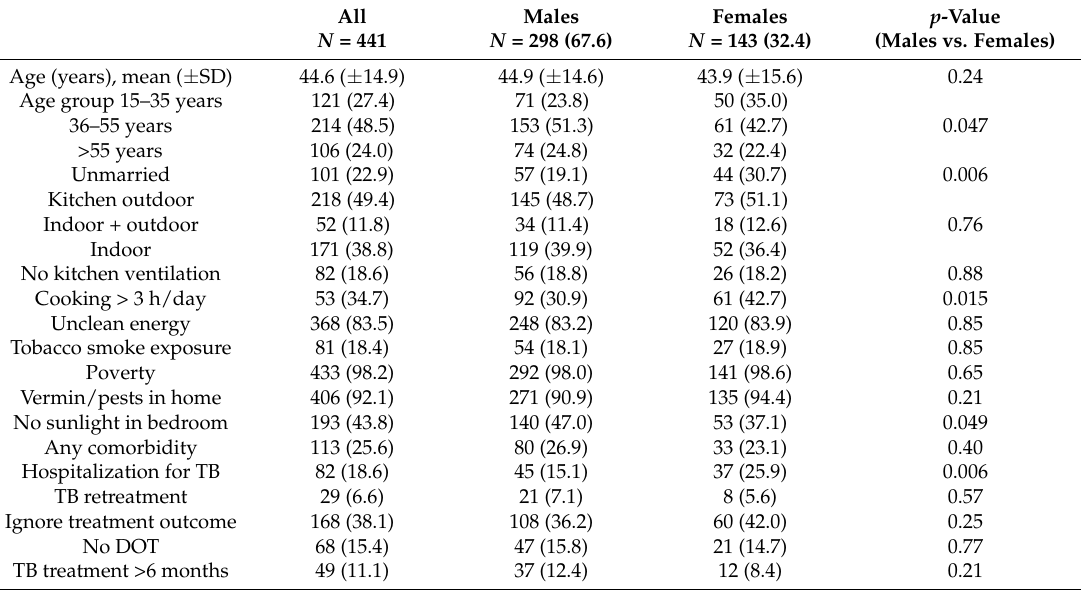
Table 1. Distribution of covariates among 441 survivors of pulmonary TB in rural DRC.